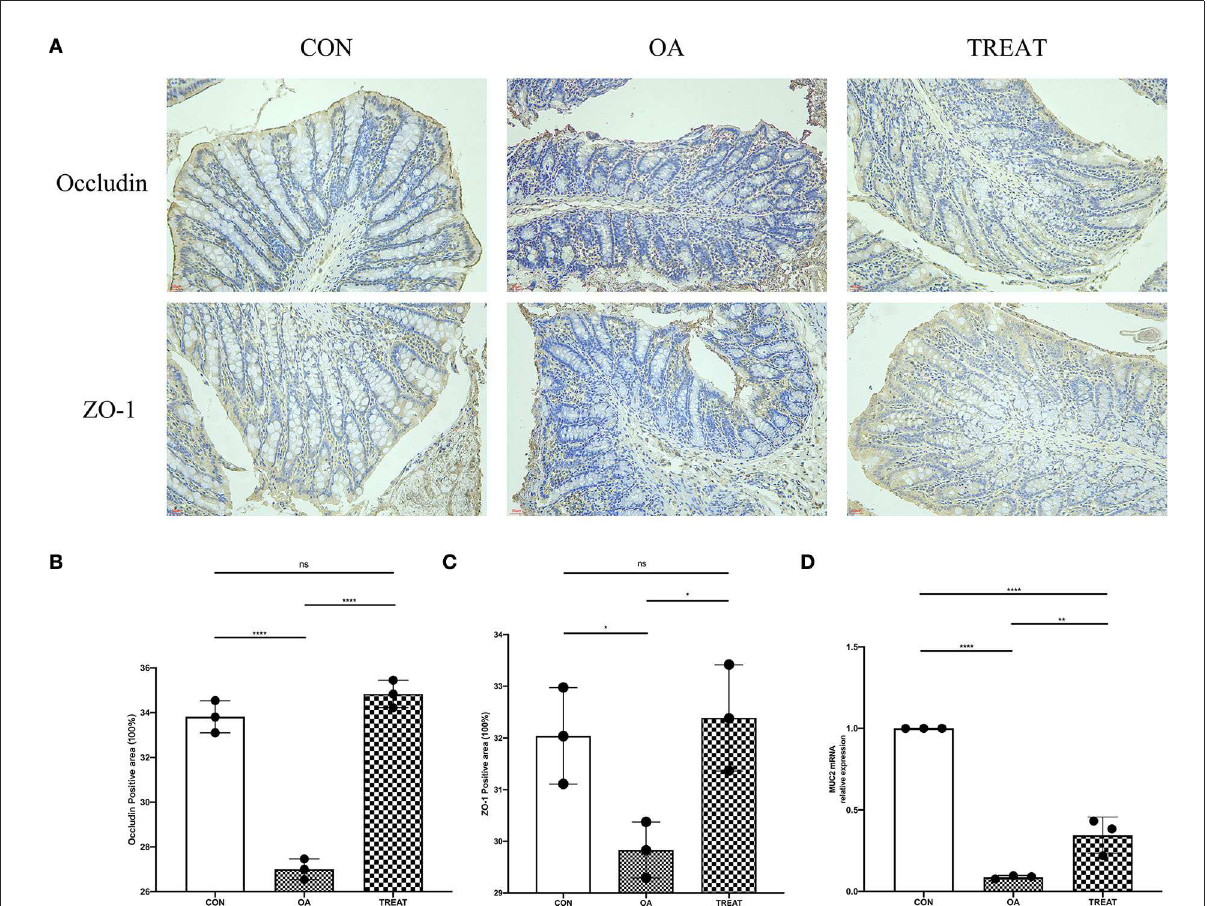
FIGURE5 Effect of the oral administration of live combined Bacillus subtilis and Enterococcus faecium on OA colonic tight junction protein and mucin mRNA expression. Representative photomicrographs are at 400 × magnification. (A) Immunohistochemical staining of occludin and ZO-1. (B) Positive-stained area for occludin. (C) Positive-stained area for ZO-1. (D) MUC2 mRNA relative expression. All data are expressed as the mean ± SD. * p < 0.05, ** p < 0.01 and **** p < 0.0001; n =